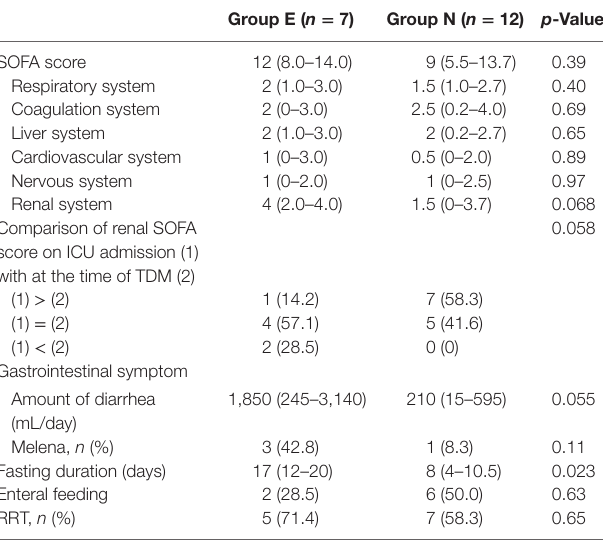
Table 3 | Clinical course at the time of therapeutic drug monitoring (TDM).